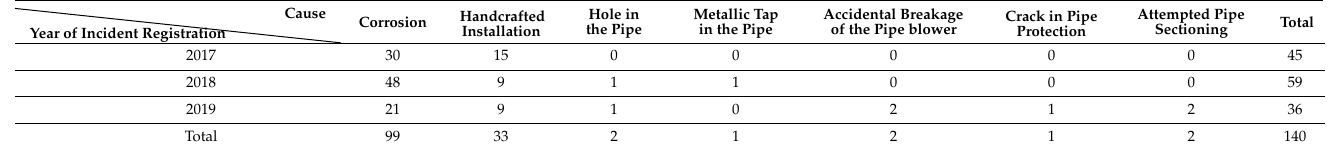
Table 12. The cross-tab for year of incident registration and cause of incident.